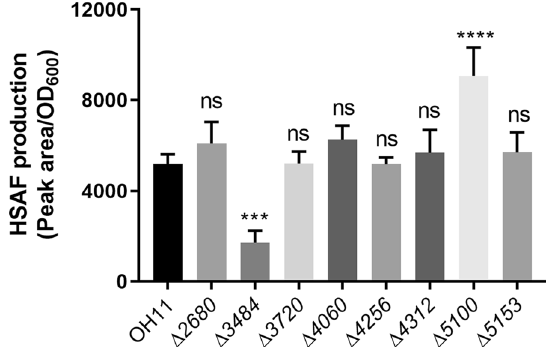
Fig. 2 Quantification of HSAF produced by the Lysobacter enzymogenes knockout mutants of the 8 potential transcription factors. Error bars, means standard deviation (n 3). *** P < 0.001, ± = **** P < 0.0001, assessed by one-way ANOVA. All experiments were repeated three times with similar